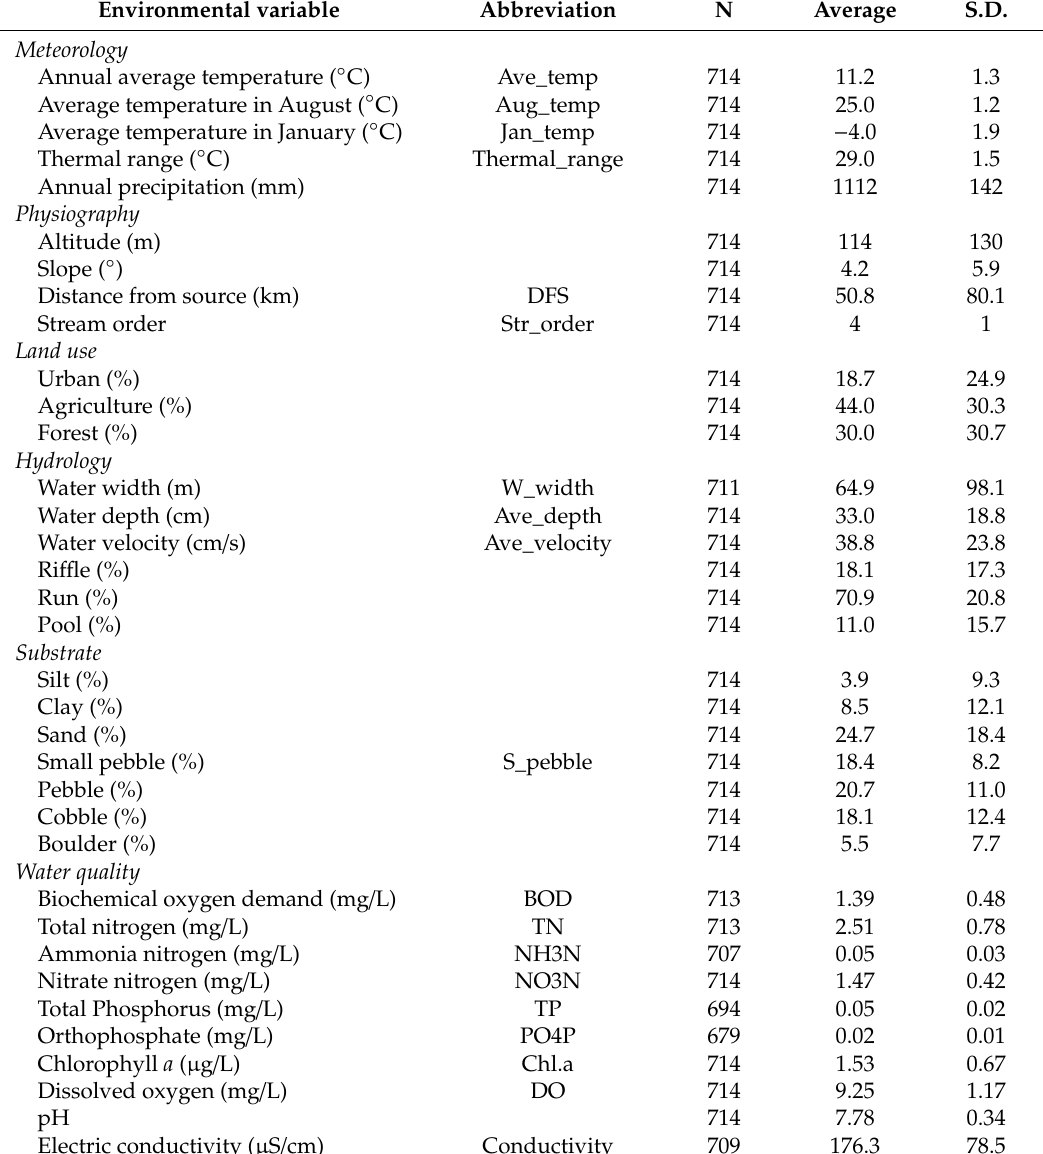
Table 1. Average values and standard deviations (SD) of the environmental variables characterizing the sampling